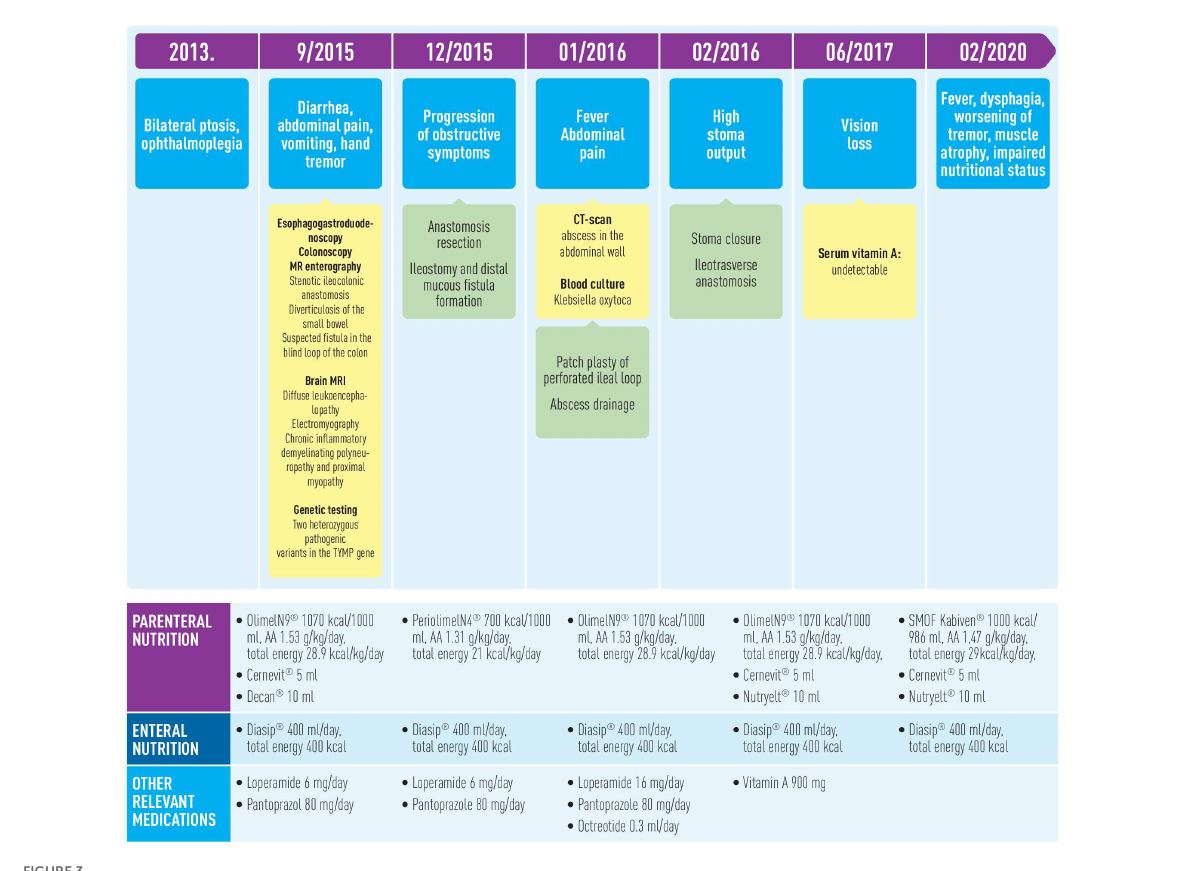
FIGURE3 Timeline of interventions and